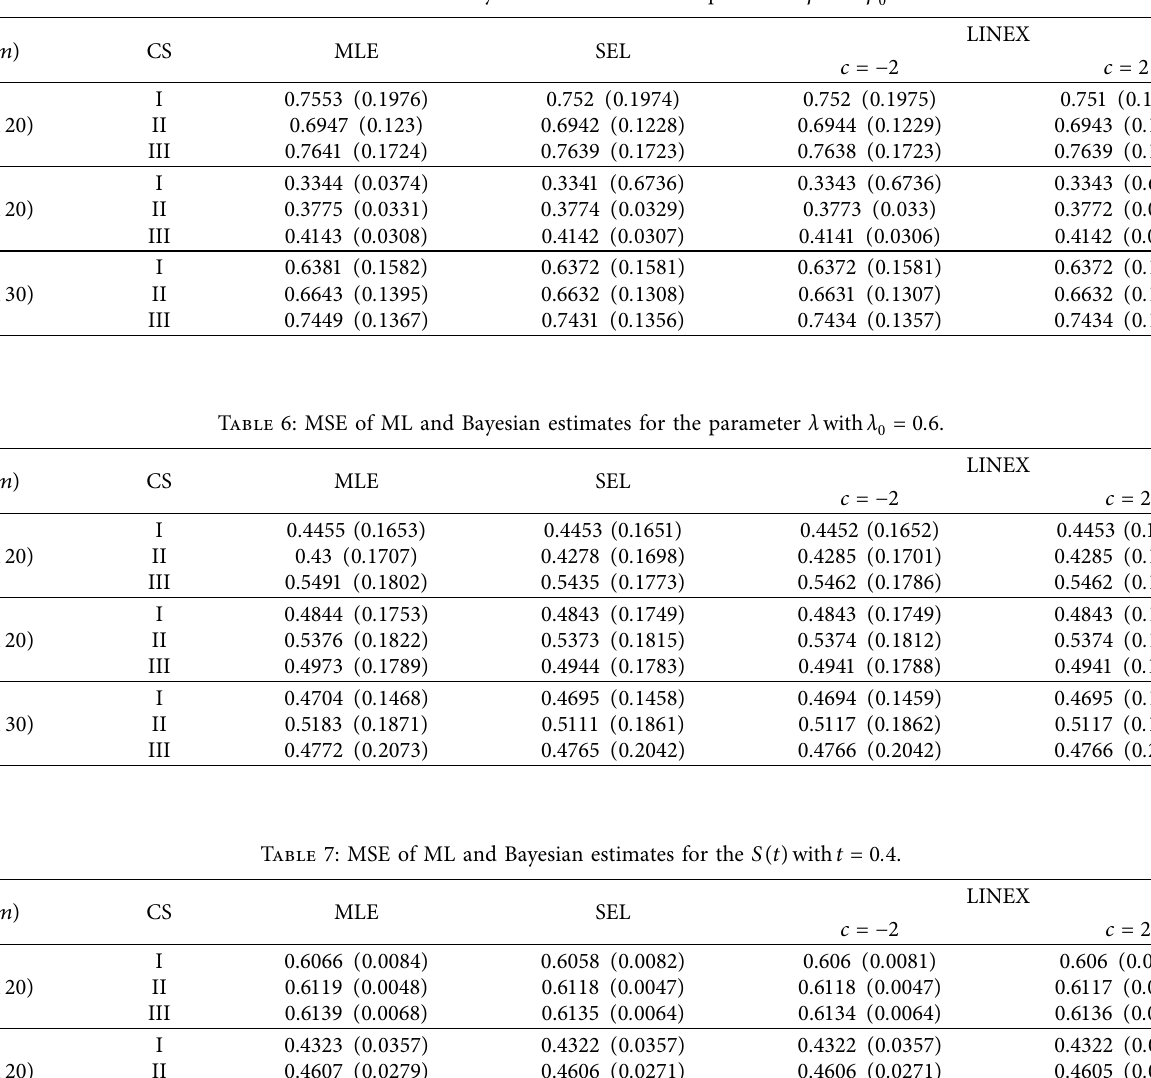
Table 5: MSE of ML and Bayesian estimates for the parameter β with β